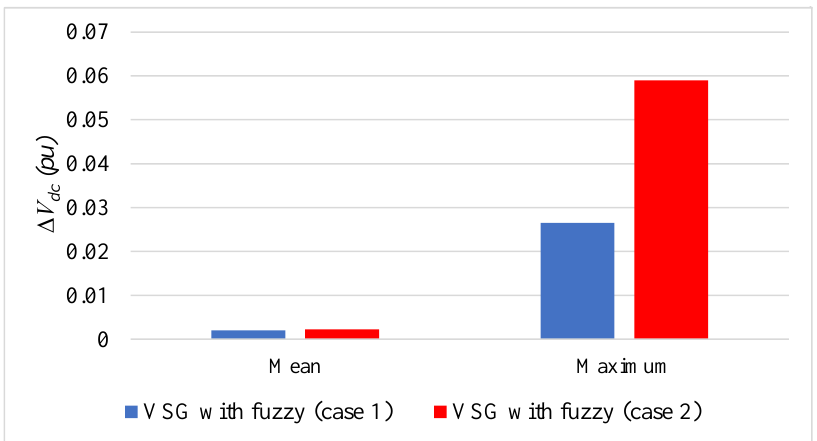
Figure 31. DC-link voltages of DER 1 for the different scenarios presented in Section 4.2.